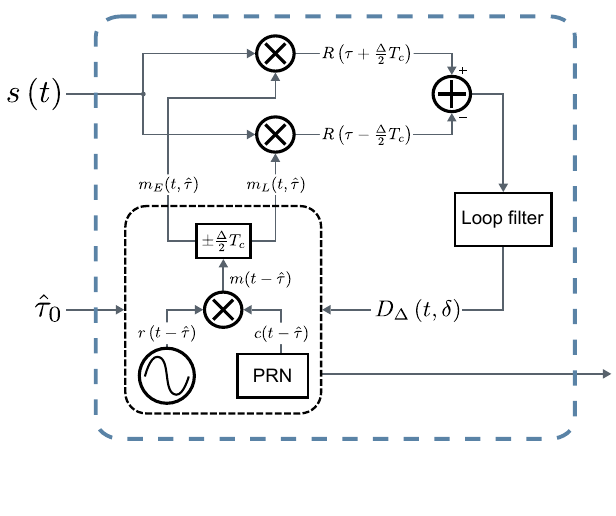
Figure 2. Diagram of the tracking stage (ELDLL).